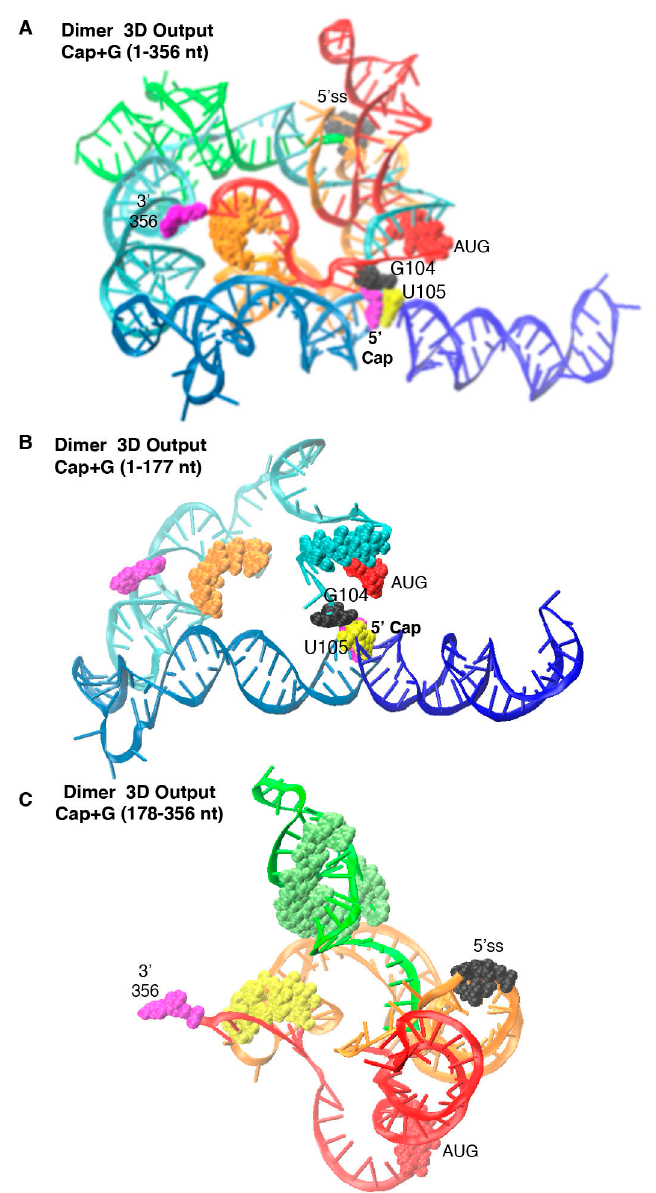
Figure 2. Dimer 3D model identified by SimRNA. ( A ) Most representative model of Dimer-prone 5 (cid:48) -UTR. ( B ) Focus on 5 (cid:48) -Cap + 1–177. ( C ) Focus on nt 178–356. Label colors designate: TAR, light blue; PolyA stem, navy; U5 stem, cyan; PBS, green; DIS and three-way junction, orange; 5 (cid:48) -Cap and 3 (cid:48) terminus, magenta atoms; G104, black atoms; U105, yellow atoms; AUG stem, red atoms. 5 (cid:48) -splice site (5 (cid:48) ss), black atoms; DIS atoms, orange ( A , B ), yellow; gag start codon, red